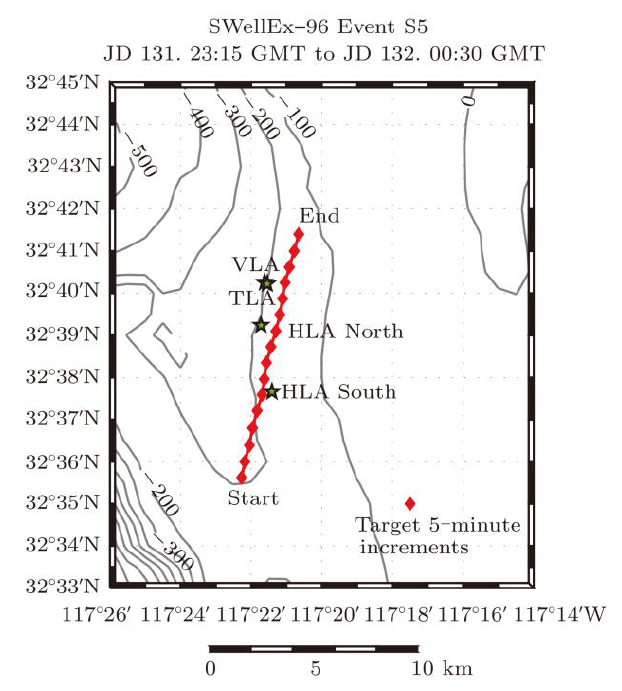
Figure 6. Map of the ship trajectory for event S5.